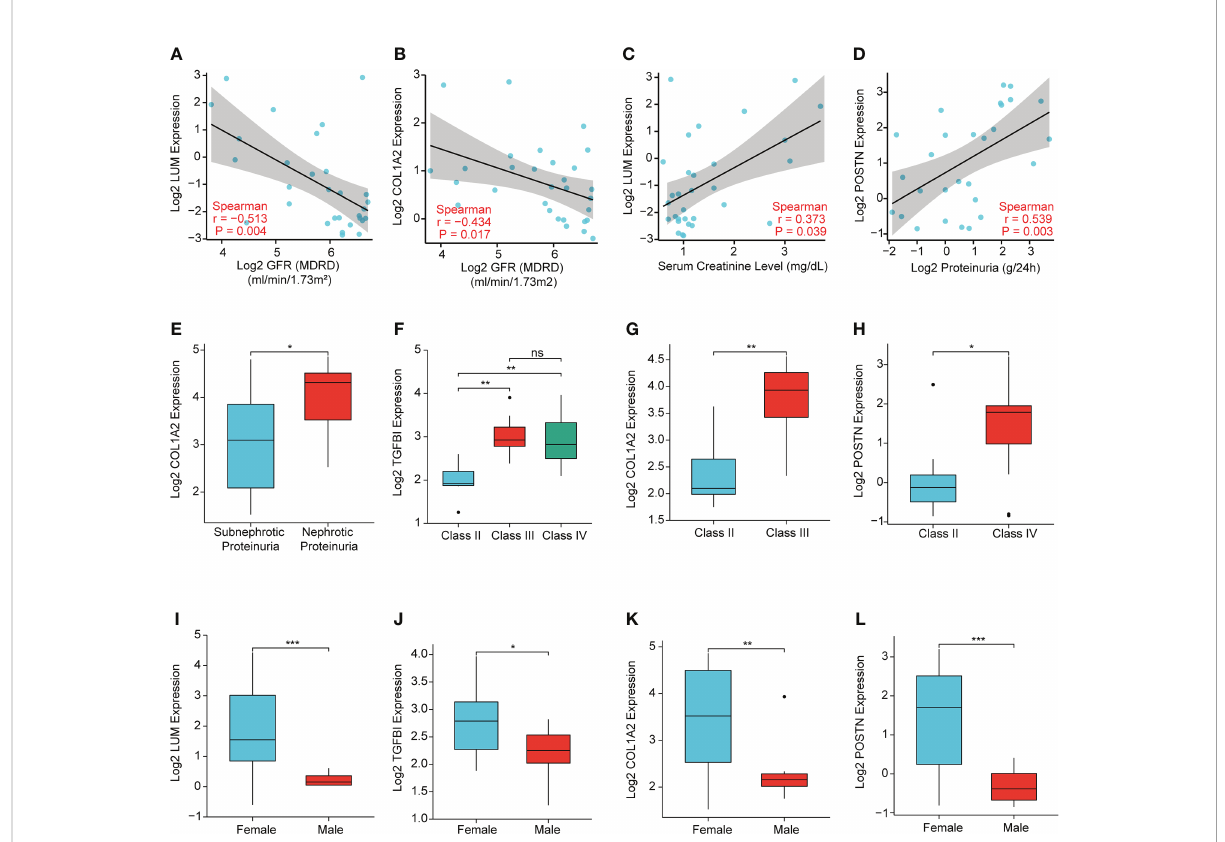
FIGURE 10 Correlation analysis of the expression levels of LUM, TGFBI, COL1A2, and POSTN with the clinicopathological features, including (A, B) glomerular fi ltration rate (GFR), (C) serum creatinine level, (D, E) proteinuria, (F – H) WHO class, and (I-L) sex. (*P < 0.05, **P < 0.01, ***P < 0.001 and ns, no signi fi